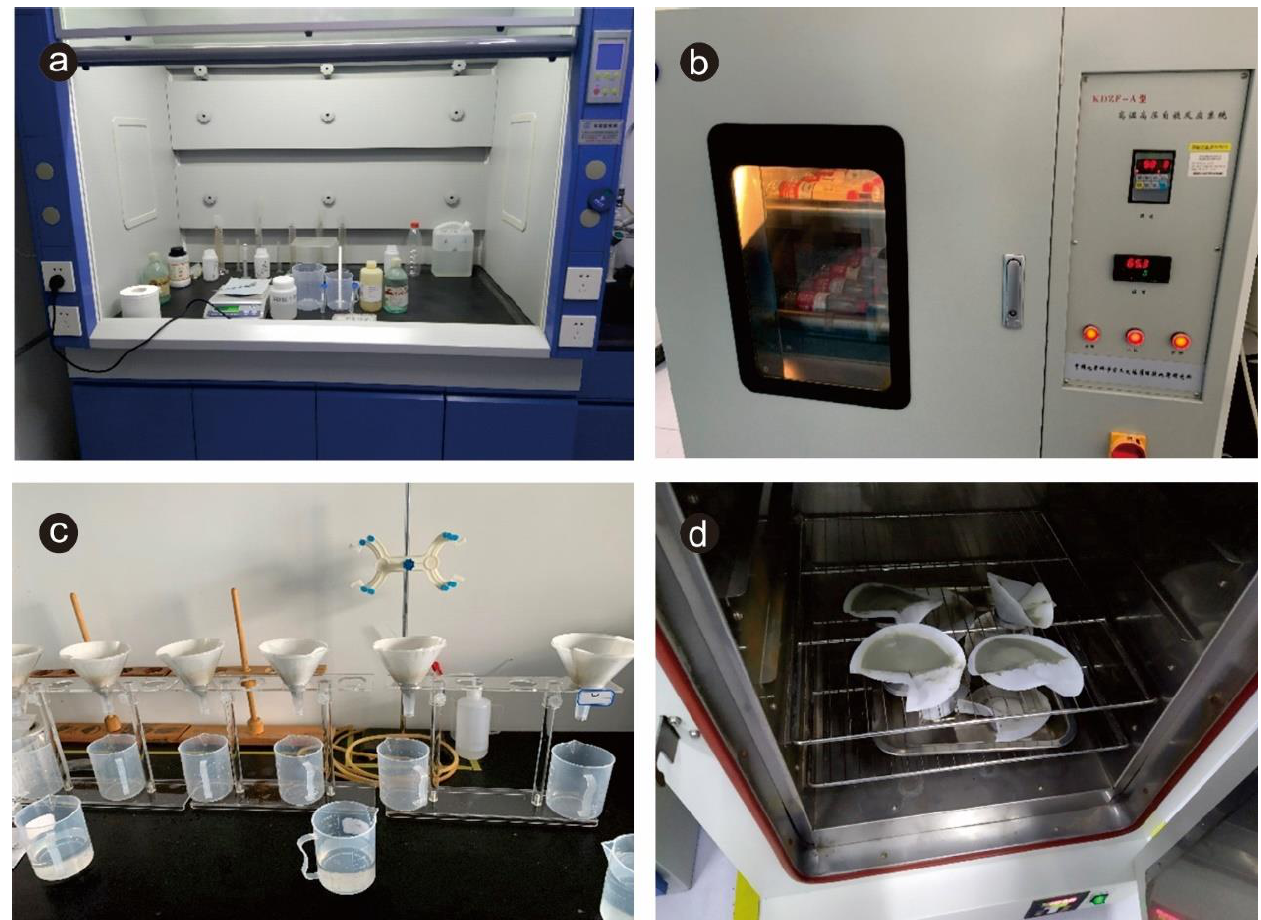
Figure 3. Experimental design and procedures. ( a ) The fume cupboard treatment of acid-added samples; ( b ) samples in the automatic rotary reactor system; ( c ) sample precipitation filtration; ( d ) precipitation placed in incubator for drying.